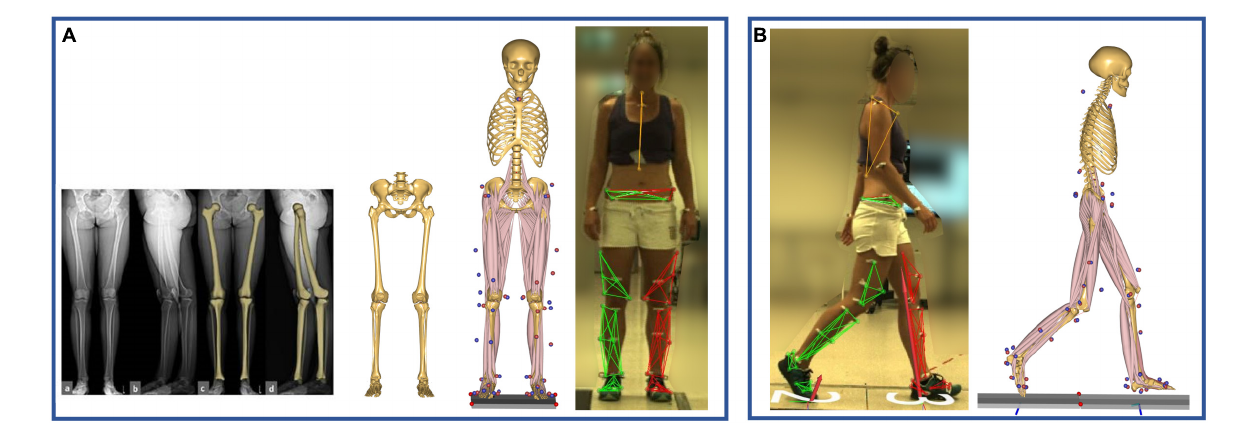
FIGURE 1 | (A) Model scaling and personalization based on subject-specific radiographic measurements, obtained through a low-dosage biplanar EOS system (EOS Imaging Inc., France). The distance between the hip joint centers, measured in the frontal plane, was used to scale the pelvic width, while the femoral torsion was calculated through 3D reconstructions of the femurs (sterEOS software, EOS Imaging Inc., France). The model was scaled to match the subject’s anthropometrics based on marker data collected during a standing reference trial. (B) Kinematic and kinetic analyses during gait were based on the tracking of the measured marker